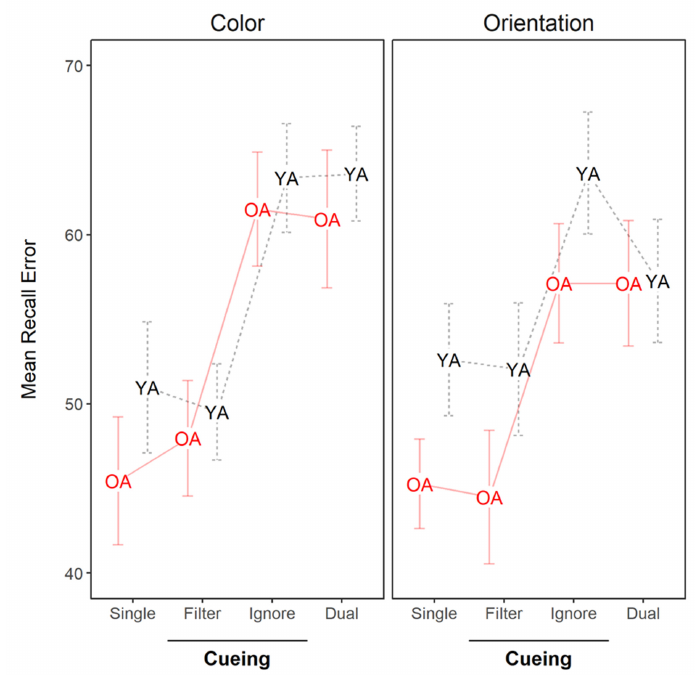
Figure 4. Mean recall error in Experiment 2 for each age group (YA = younger adults, OA = older adults), recall (color and orientation), and baseline condition (Single and Dual) and cueing condition (Filter and Ignore).